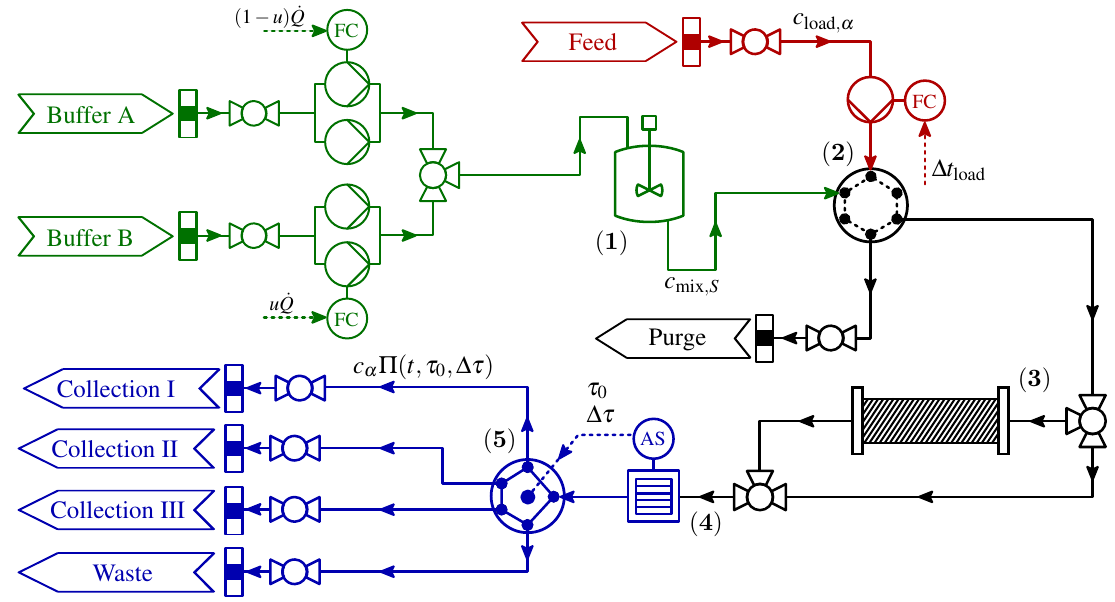
Figure 1. Simplified P&ID of the HPLC system. Elementary system component description: (1) buffer mixing unit, (2) high-pressure switching valve unit, (3) HPLC separation column, (4) UV detector, and (5) fractionating